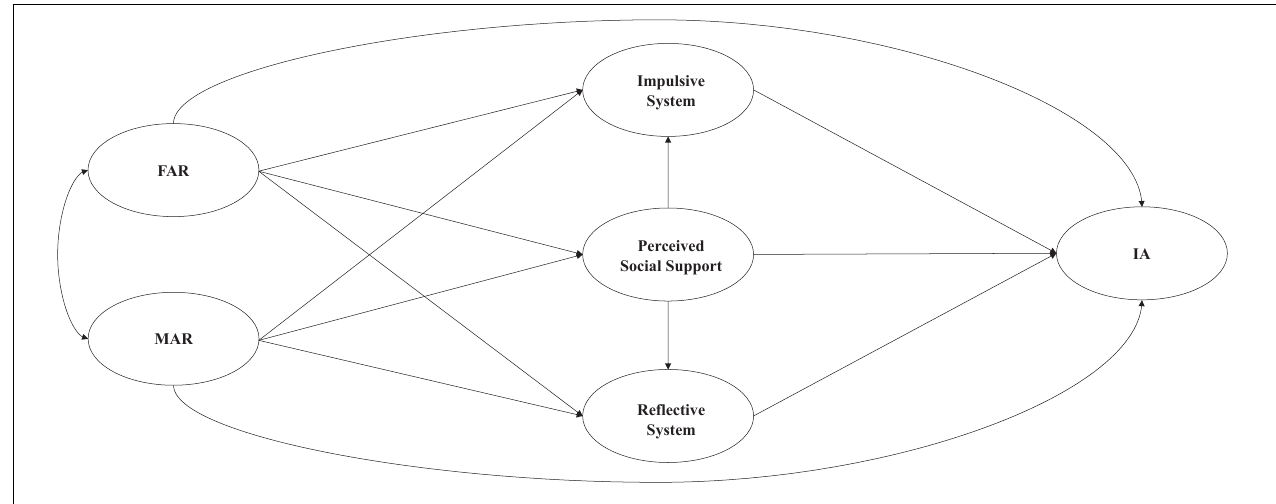
FIGURE 1 | The hypothesis